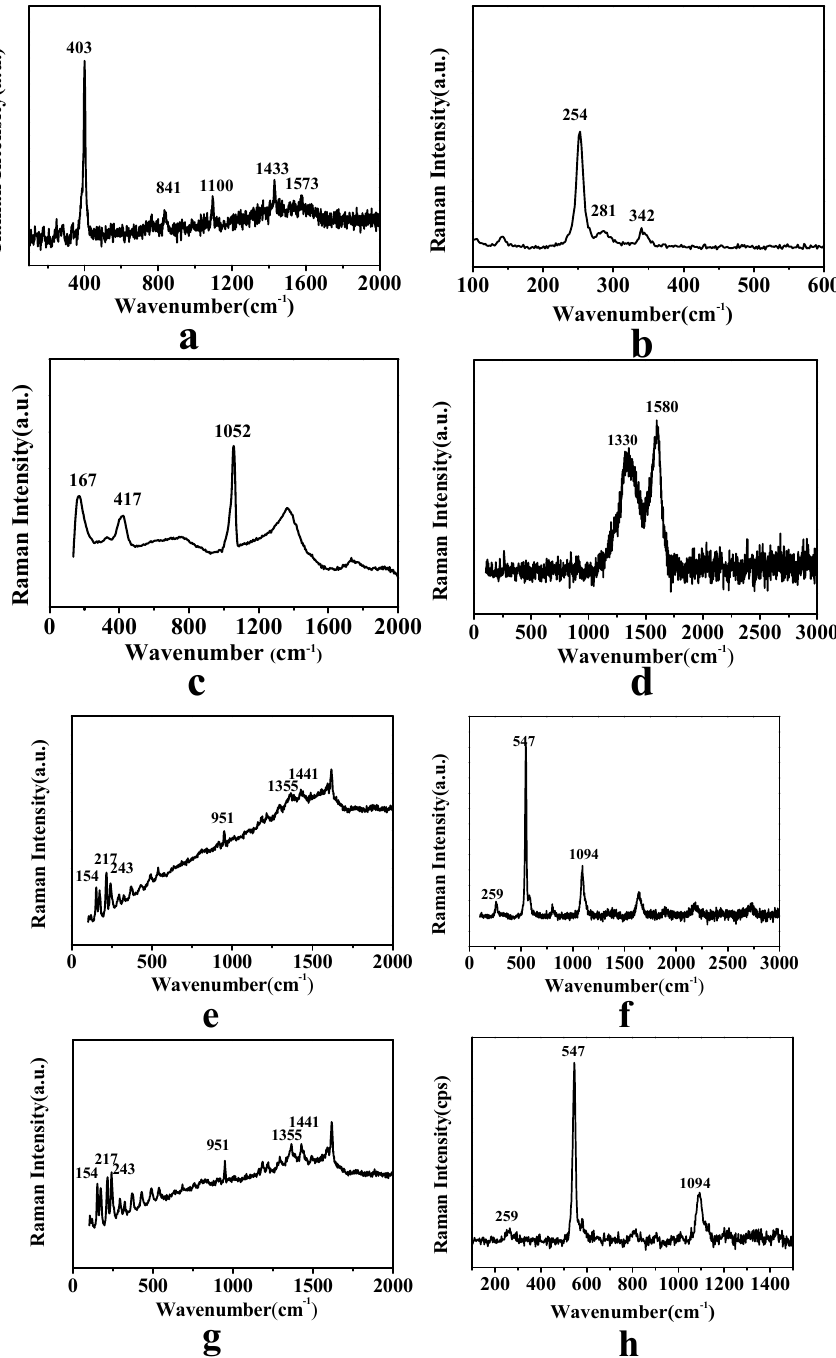
Figure 3. ( a ) Raman spectra for the blue pigment (azurite; 2CuCO 3 · Cu(OH) 2 ) in M2 sample; ( b ) Raman spectra for the red pigment (vermilion; HgS) in M3 sample; ( c ) Raman spectra for the white pigment(lead-white; 2PbCO 3 · Pb(OH) 2 ) in M4 sample; ( d ) Raman spectra for the black pigment (carbon black; C) in L1 sample; ( e ) Raman spectra for the green pigment (emerald green; Cu(CH 3 COO) 2 · 3Cu(AsO 2 ) 2 ) in L2 sample; ( f ) Raman spectra for the blue pigment (ultramarine; (Na,Ca) 8 (AlSiO 4 ) 6 (SO 4 ,S,Cl) 2 ) in L3 sample; ( g ) Raman spectra for the green pigment (emerald green; Cu(CH 3 COO) 2 · 3Cu(AsO 2 ) 2 ) in X1 sample; ( h ) Raman spectra for the blue pigment (ultramarine; (Na,Ca) 8 (AlSiO 4 ) 6 (SO 4 ,S,Cl) 2 ) in X2 sample.